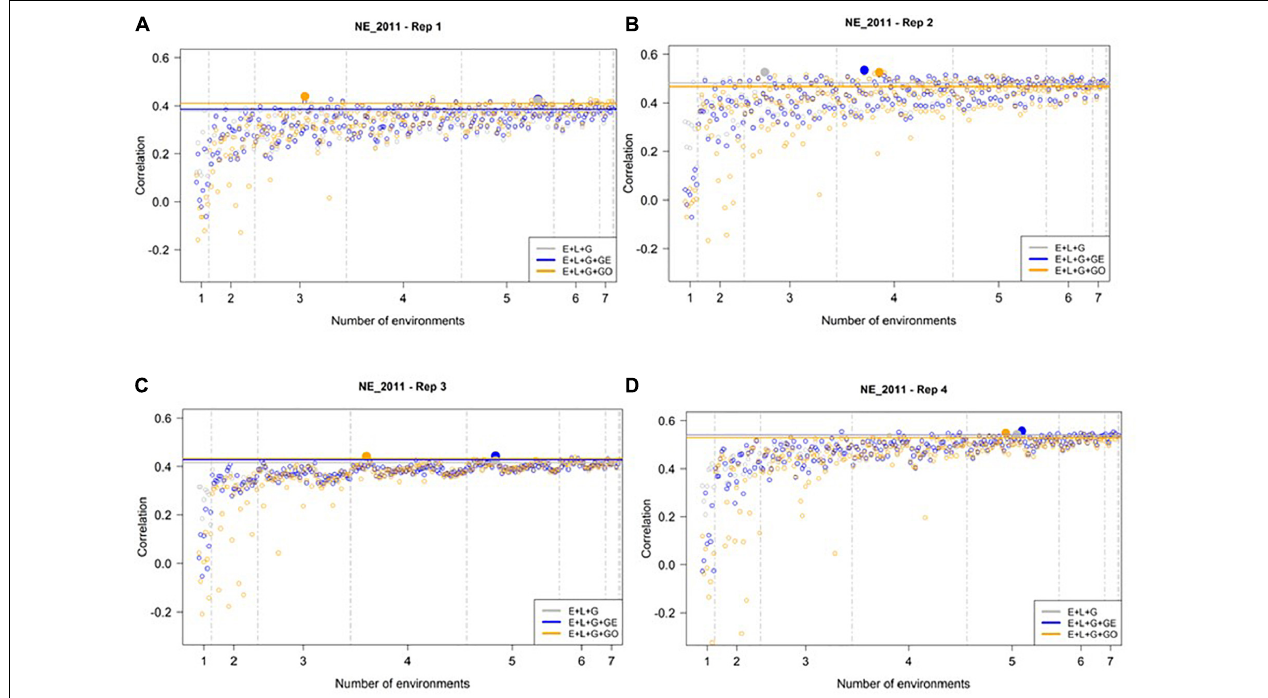
FIGURE 4 | Observed prediction accuracy of grain yield in kg ha − 1 at NE_2011 across multiple genomic prediction (GP) models and training environments. Four random samples of 500 genotypes from the SoyNAM panel are presented in panels (A–D) . For each panel, the X -axis is the specific number of environments considered for training the GP model, sorted from smallest to largest number of training environments; and the Y -axis shows the prediction accuracy, quantified as the Pearson correlation coefficient between the observed phenotypic values and the genomic estimated breeding values. The results in grey depict the GP model without any genotype-by-environment (G × E) interaction effects, while the results in blue depict the GP model with G × E interaction effects, and finally the results in yellow depict the GP model with G × E interaction effects that incorporates environmental covariates (ECs). The highest observed prediction accuracies across any training set from each GP model are highlighted by a solid circle of the same color, while the prediction accuracies of the three models obtained using all eight of the possible environments in the training set are shown as horizontal lines of the same color. These panels show that not all eight environments are needed to obtain the maximum possible prediction